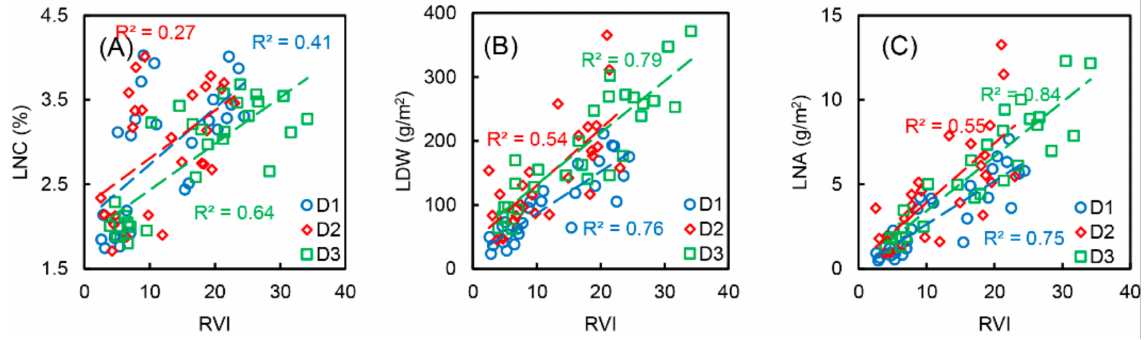
Figure 12. Correlation of RVI with LNC ( A ), LDW ( B ), and LNA ( C ) under different row widths; D1, D2, and D3 represent row widths of 50, 35, and 20 cm,